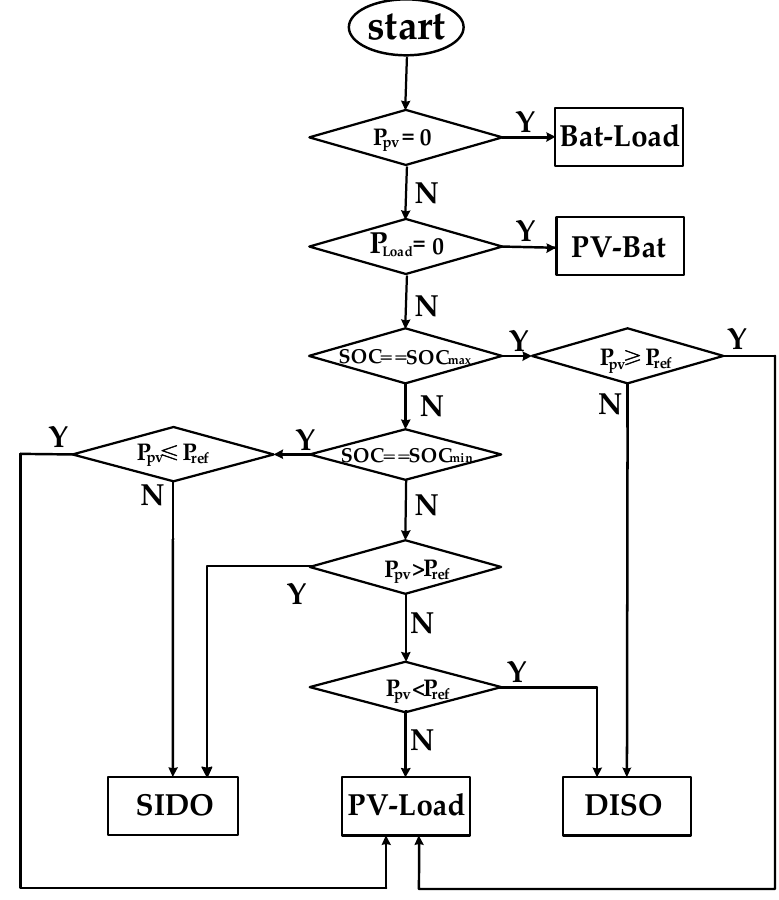
Figure 3. Topological working state.